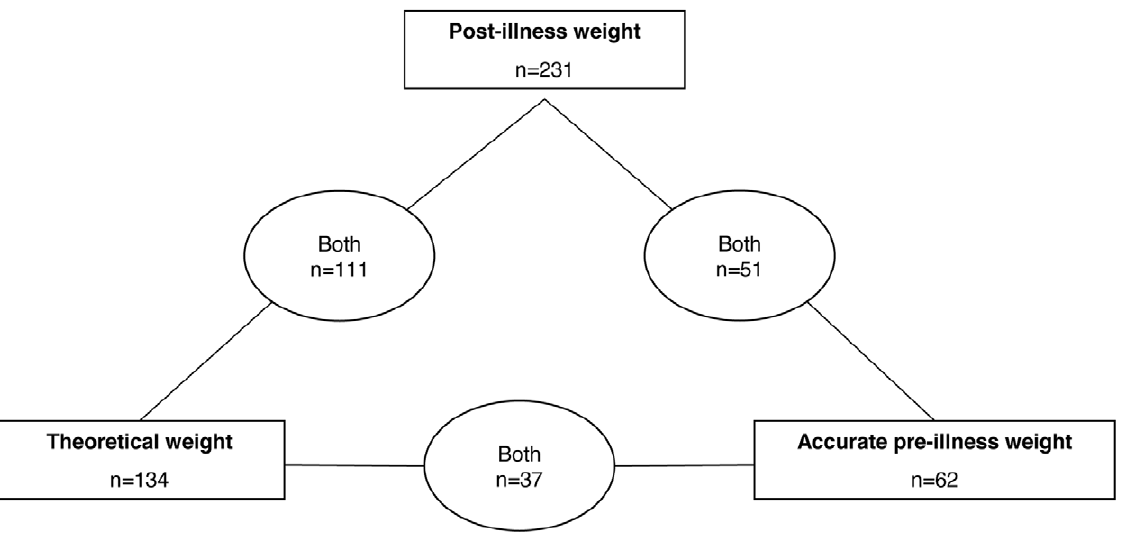
Figure 1. Distribution of children with acute diarrhea by available methods of measure of the weight (n=293). Pre-illness weight : measured within 8 days before the ED visit. Theoretical weight : predicted from the child’s individual growth chart. Post-illness weight : the first weight when two consecutive daily weight measurements differed by , 1%, after diarrhea and vomiting had disappeared.